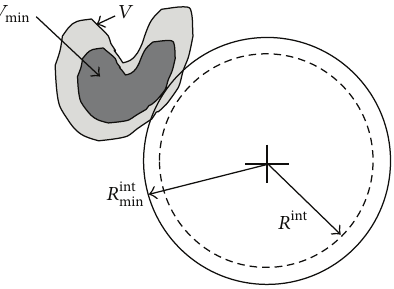
Figure 4: This figure expands the interpretation of Figure 3. It illustrates the relations between 𝑉 min and 𝑉 , and 𝑅 min and 𝑅 , for the same source and origin shown in Figure 3.